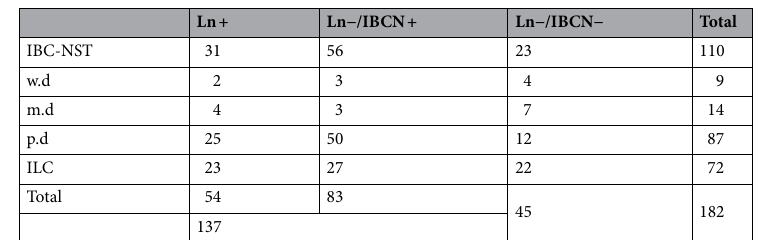
Table 3. Distribution of lymph nodes, through respective subtypes of IBC. Ln + number of metastatic lymph nodes from cases with nodal metastatic disease, Ln−/IBCN + number of non-metastatic lymph nodes from cases with nodal metastatic disease, Ln−/IBCN− number of lymph nodes with reactive hyperplasia from cases without nodal metastatic disease, IBC-NST invasive breast carcinoma of no special type w.d. well differentiated, m.d. moderately differentiated, p.d. poorly differentiated, ILC invasive lobular